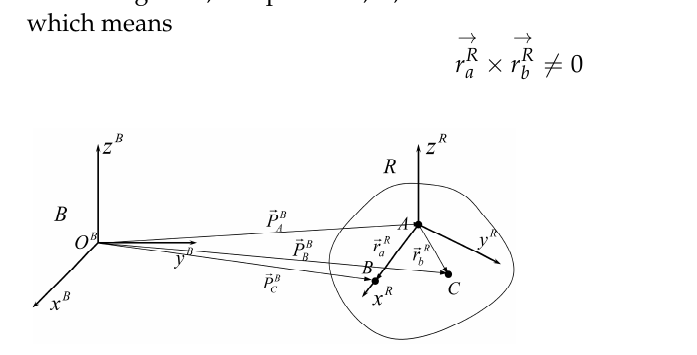
Figure 2. Pose of rigid body.